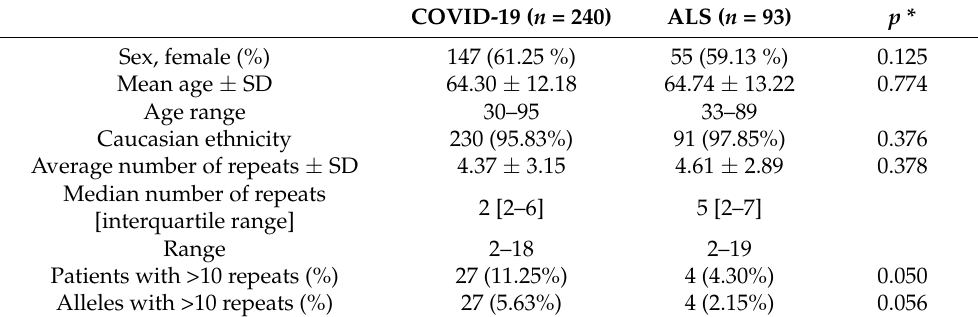
Table 1. Demographic data and C9orf72 hexanucleotide expansions in the cohort of 240 coronavirus disease 2019 (COVID-19) and 93 amyotrophic lateral sclerosis (ALS) patients.